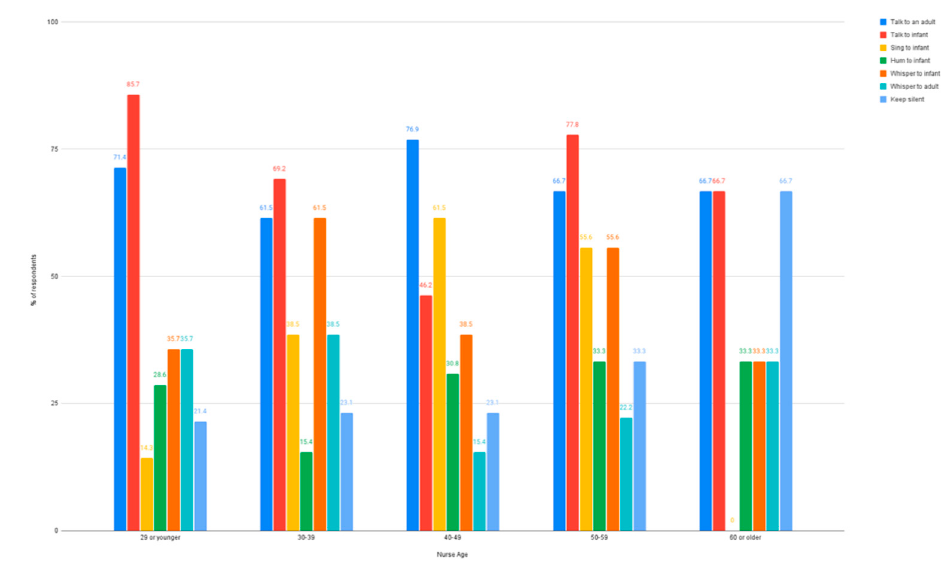
Figure 6. Types of voice use separated by the age of the nurse.